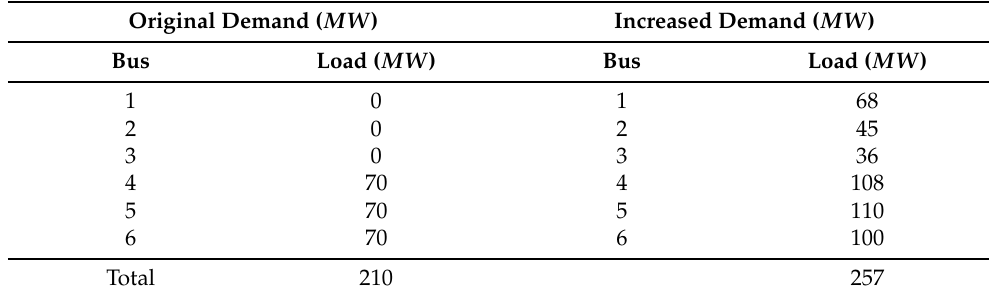
Figure 1. The 6-bus system’s load profile in base and increased demand scenarios. Table 2. The 6-bus system of the base year demand versus increment in energy demand.